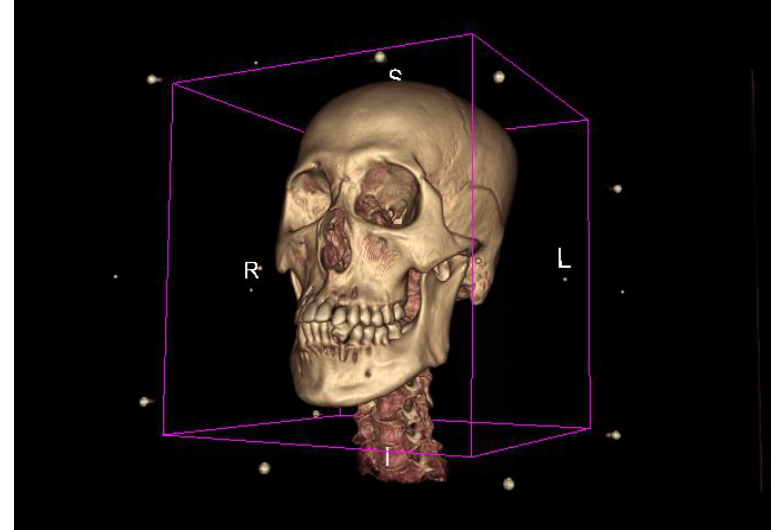
Figure 2. CT rendering of the brain model.